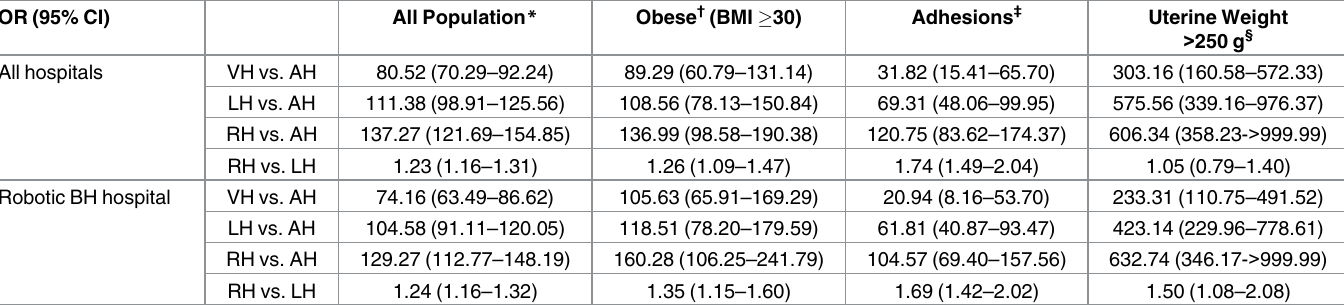
Table 3. Estimated effectsof surgical approaches on the likelihood of outpatient BH, 2014 (N =